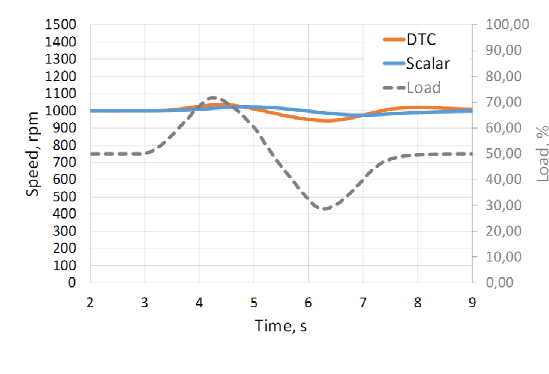
Fig. 9. Drive speed response on variable load of pulse profile.